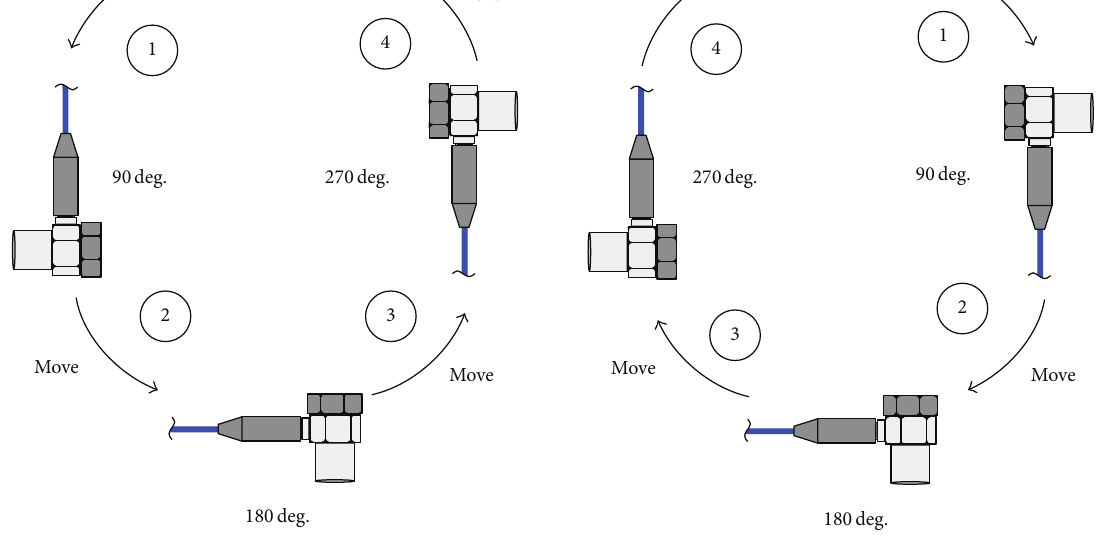
Figure 3: Sensor movement tests.